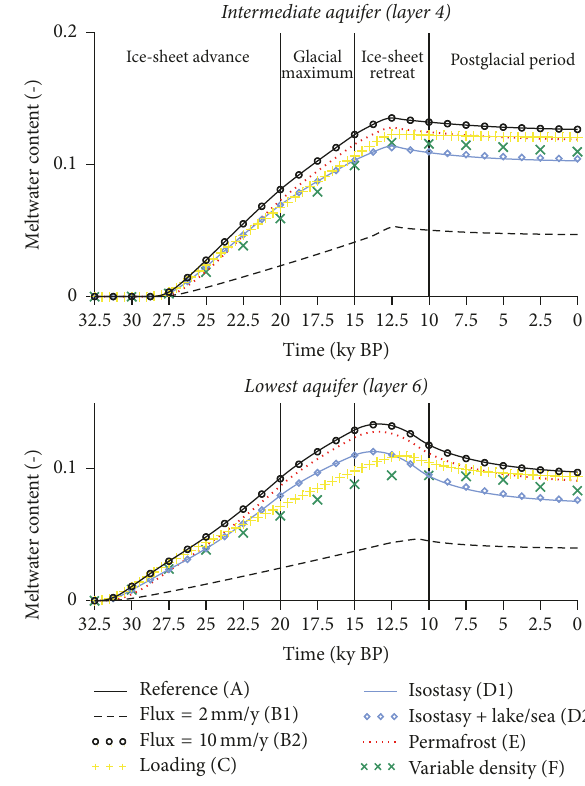
Figure 4: Groundwater flow rates in all simulations, in the two deepest aquifers simulations at 27 ky BP. Distances to the ice-sheet front are negative beneath the ice-sheet and positive in periphery.